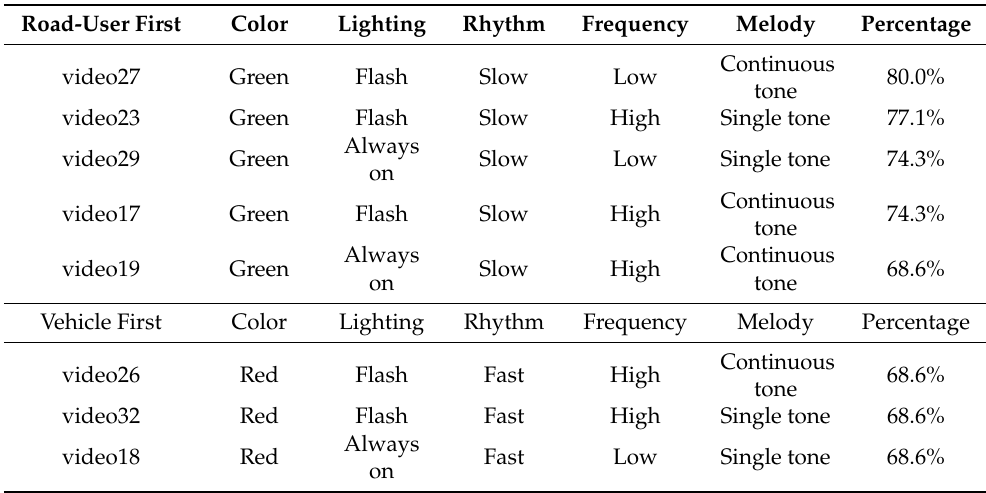
Table 10. Percentage of intention with different variable combinations for road-user first and vehicle first in waiting-to-restart